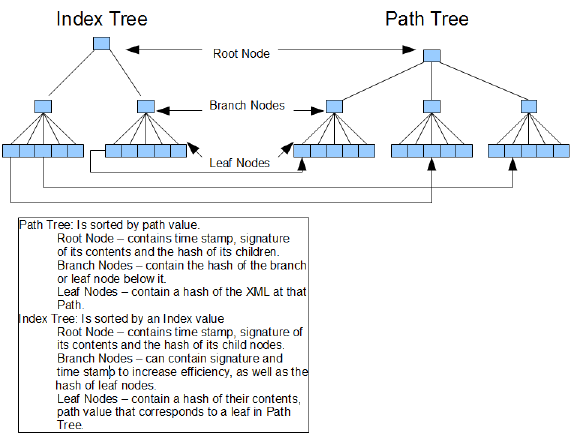
Fig. 2. Verification Tree